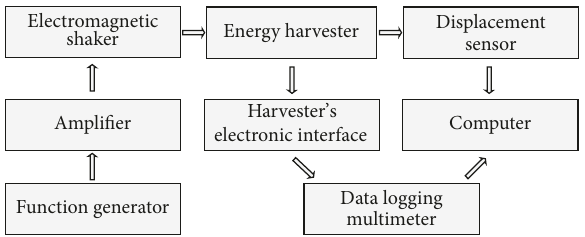
Figure 11: Neat diagram of the experimental